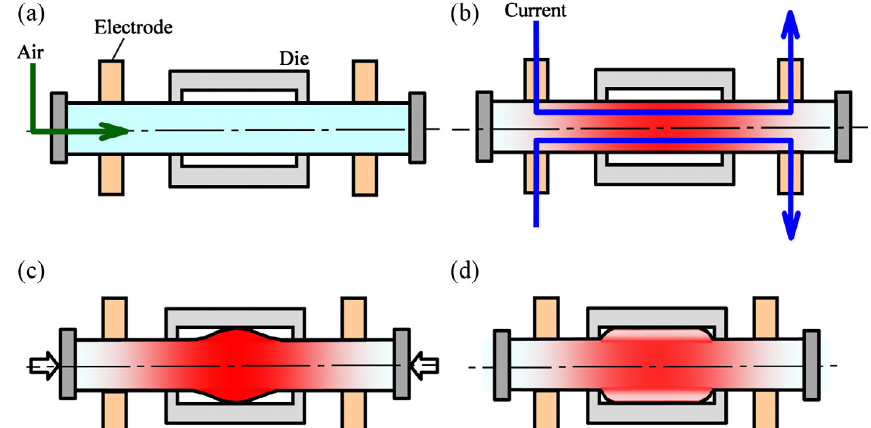
Figure 1. Sequence of hot gas bulging of sealed aluminium alloy tube using resistance heating. (a) Charge with compressed air, (b) start of heating, (c) start of axial feeding and (d) ends of heating and axial feeding.